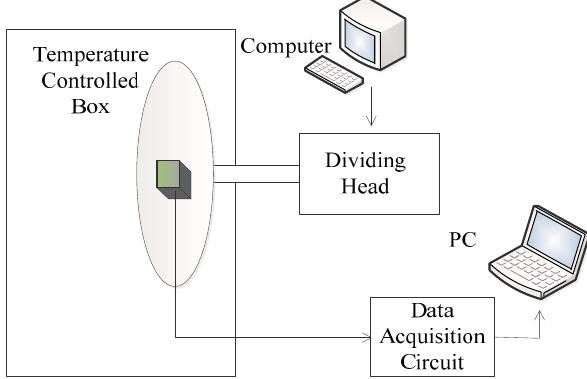
Figure 4. Illustration of the experiment.